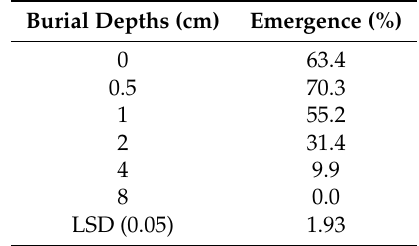
Figure 6. The e ff ect of the pH level on the seed germination of three biotypes of Brachiaria eruciformis . Each bar of the graph represents a mean value of the germination data (pooled across biotypes), as no significant di ff erences were observed among biotypes. The vertical bar shows the least significant di ff erence (LSD) values at the 5% level of probability.